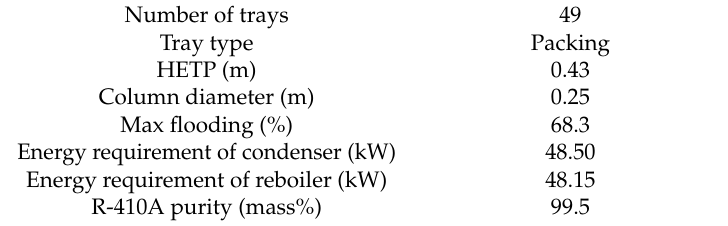
Figure 2. Simplified flowchart illustrating the existing conventional column for R-410A reclamation. Table 1. Existing conventional distillation columns' hydraulics, energy performance, and product specifications.